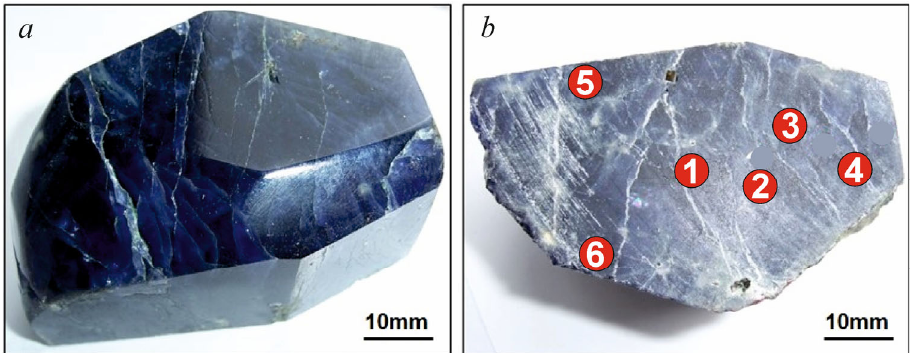
Figure 2. Photographs of the original cordierite crystal from the Muzkol metamorphic complex, Tajikistan ( a ), and its cut ( b ) with the indicated sampling sites (No. 1–6) for GC ‐ MS analysis. Electron microprobe analysis shows minor statistically insignificant variations in the composition of cordierite (Table 1) picked from different parts of the sample. The average crystal chemical formula of cordierite is Na 0.08 (Mg 1.87 Fe 0.25 Mn 0.002 ) 2.1 Al 3.9 Si 4.99 × H 2 O. The magnesian number of cordierite ( X Mg = Mg/(Fe Mn Mg)) varies from 0.880 to 0.886. The formation temperature was determined from sodium content using the following for ‐ mula: T (°C) = (Na [apfu] − 0.4052)/( − 0.000487) [59]. The average temperature for 12 anal ‐ yses was 672 °C. The evaluated metamorphism temperature based on sodium content in cordierite almost corresponds to the above ‐ mentioned temperature [102]. Table 1. Chemical analysis of cordierite from the Muzkol metamorphic complex, Tajikistan (wt.%). Cordierite from the Muzkol Complex Component